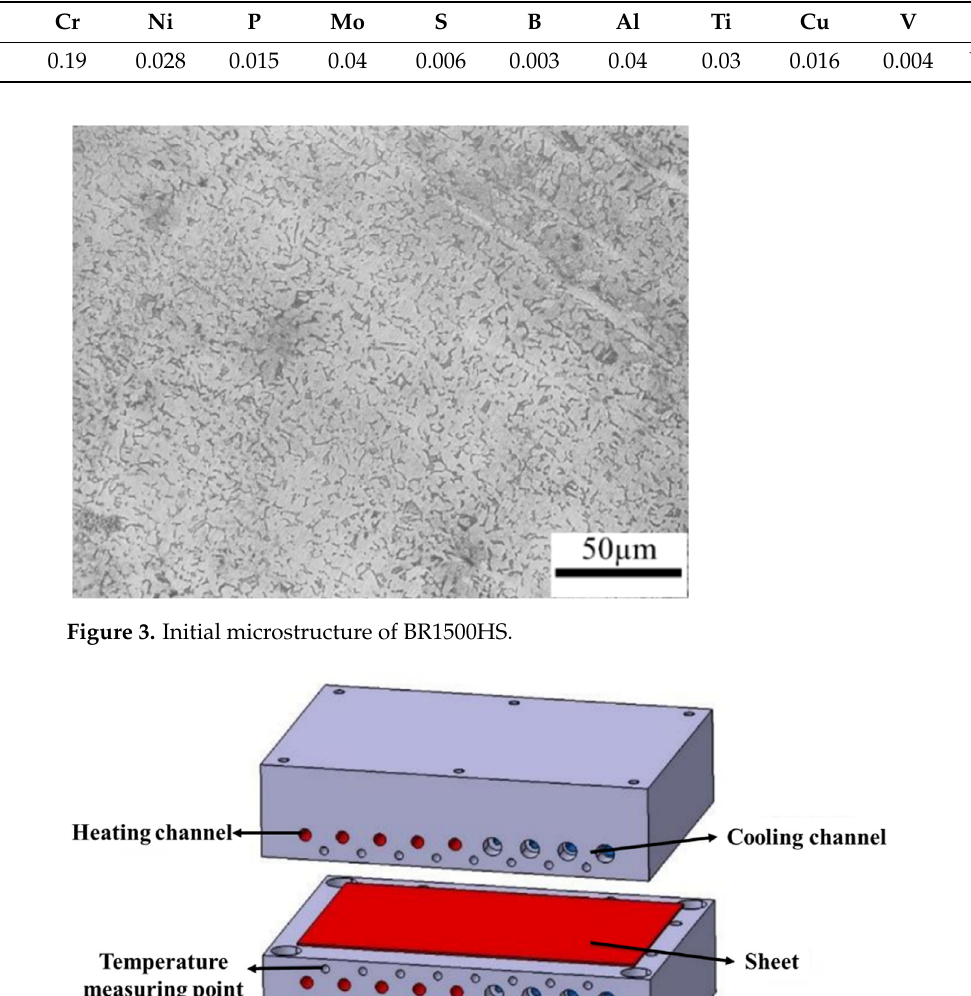
Table 1. Composition of BR1500HS sheet metal used in this work (wt.%).